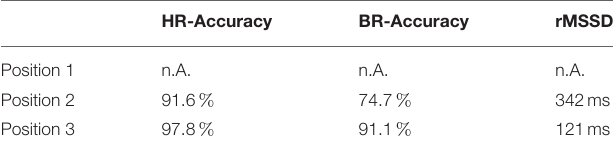
TABLE 1 | Subject 1: Accuracy of HR and BR.